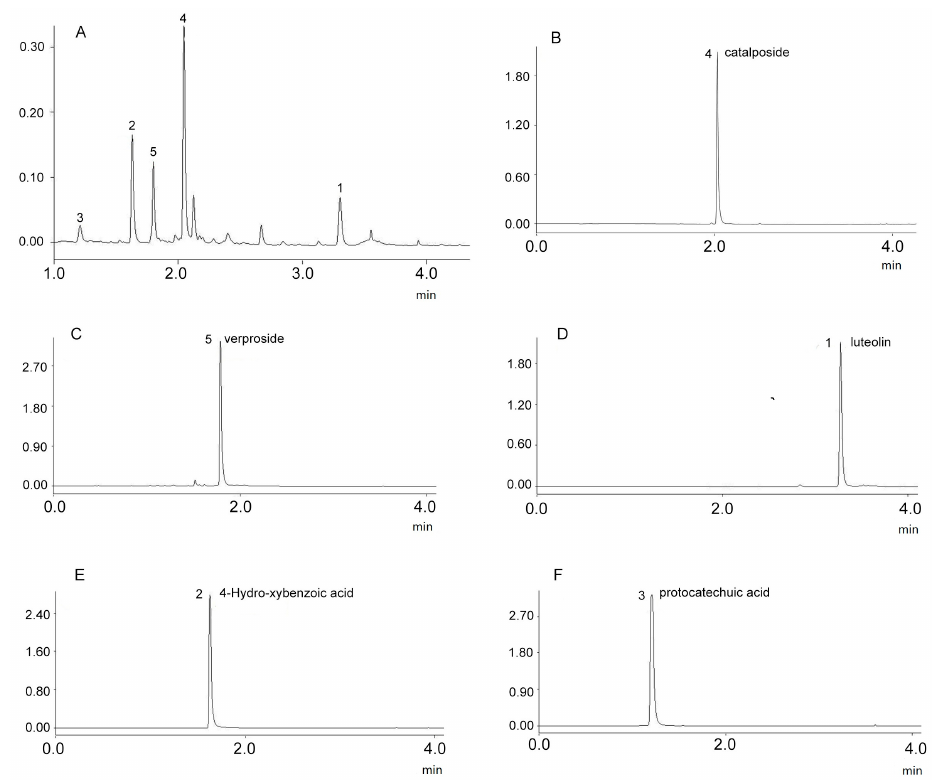
Figure 2. UPLC chromatograms of the sample ( A ) and the target compounds purified by HSCCC separation fraction ( B – F ).